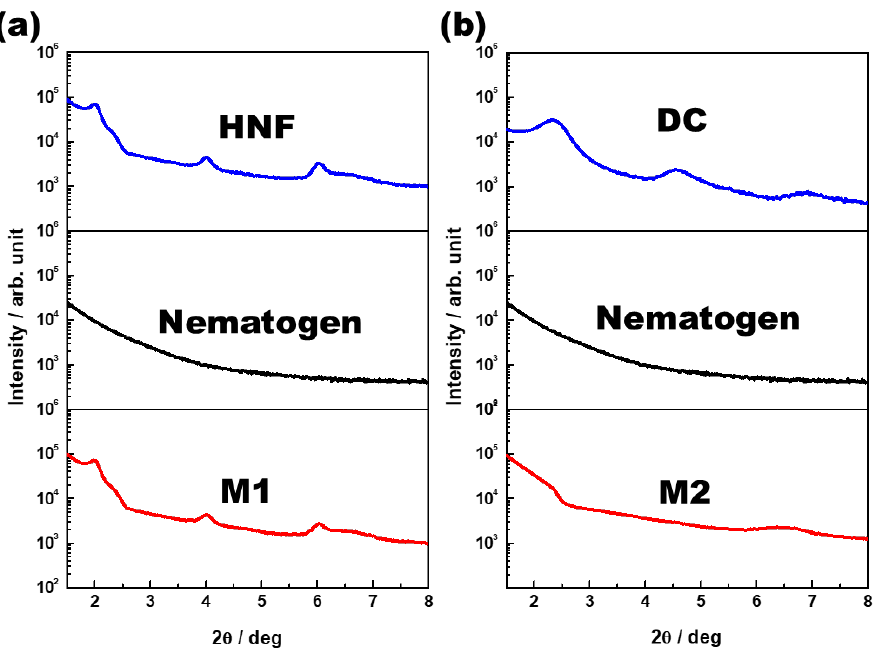
Figure 5. ( a ) X-ray diffraction (XRD) patterns of the pure HNF (BC-A), pure nematogen (5CB), and M1 (at 30 °C). ( b ) XRD patterns of the DC (BC-B), pure nematogen (5CB), and M2 (at 30 °C).